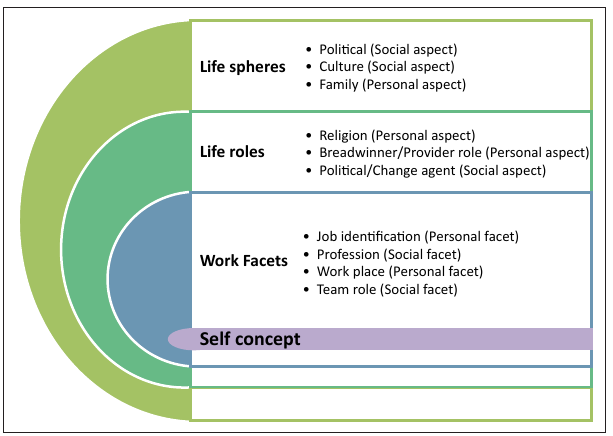
FIGURE 2: Significant elements within the multiple layers and facets of work- based